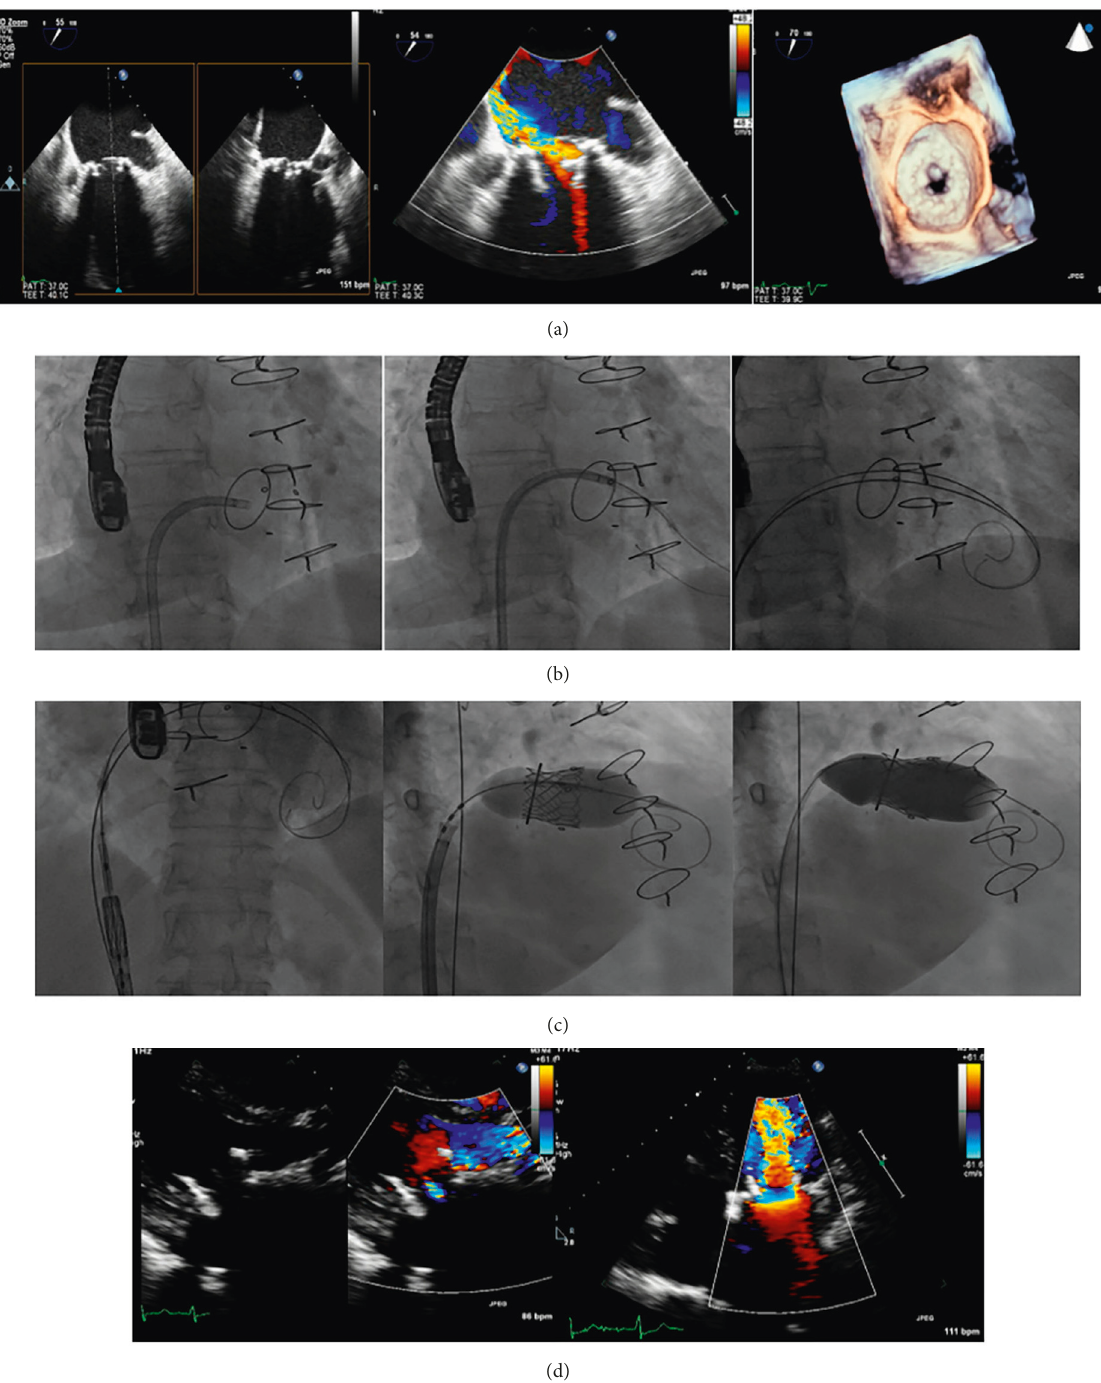
Figure 4: Transcatheter mitral valve in a degenerated Hancock ™ II (Medtronic) valve (TMViV). A 66-year-old diabetic male patient, with ulcerative colitis, had a degenerated bioprosthetic 29mm Hancock ™ II MV with an associated AF. TEE and 3D-TEE show a degenerated bioprosthetic 29mm Hancock ™ II MV (severe MS and severe MR). (b) Fluoroscopy shows an 8.5F-agilis ™ sheath was flexed and directed towards the degenerated bioprosthetic MV. A 5F-MP catheter over a 0.035-inch curved Terumo guidewire crossed the MV to the LV. The wire was exchanged with a 0.035-inch/260 extra-stiff Confida ™ guidewire and a 0.035-inch/260 J-curve super-stiff Amplatz ™ guidewire. (c) Fluoroscopy shows TMViV implantation of an Edwards SAPIEN-3 26 mm valve within the degenerated bioprosthetic MV, followed by post-TMViV distal valve flaring. D: TTE: an Edwards SAPIEN 3 26mm valve in the MV position with normal Pg, and trivial with a valvular leak. AF: atrial fibrillation, 3D: three-dimensional, MR: mitral regurge, MS: mitral stenosis, MV: mitral valve, MVA: mitral valve area, Pg: pressure gradient, TMViV: transcatheter mitral valve-in-valve, TEE: transesophageal echocardiography, TTE: transthoracic